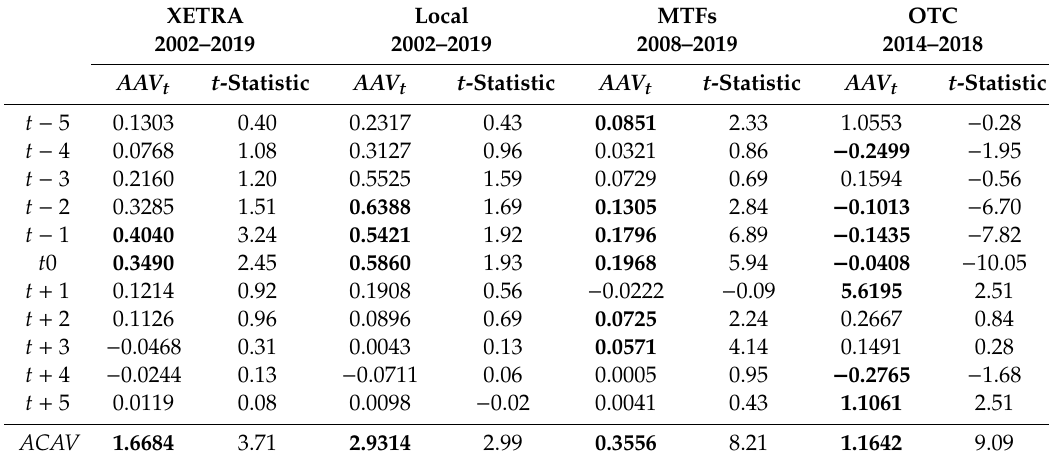
Table 6. Average abnormal number of stocks traded around